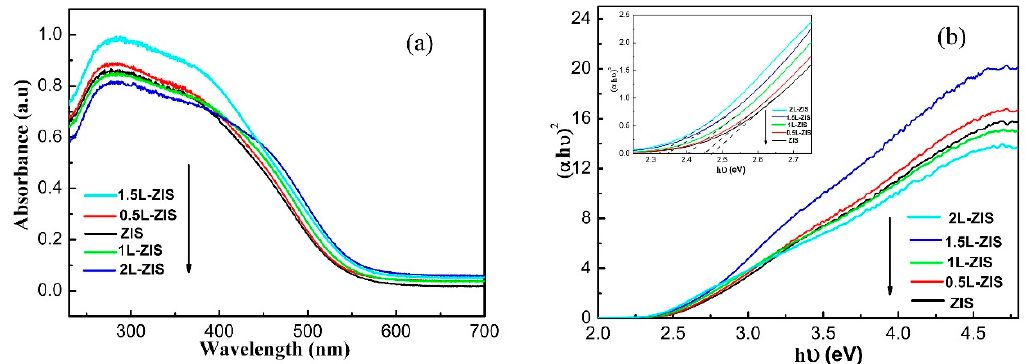
Figure 7. ( a ) Ultraviolet–visible (UV–vis) absorbance spectra of P-ZIS and La-doped ZIS samples; ( b ) the derived plots of ( α hv ) 2 versus hv from the absorption spectrum for P-ZIS and La-doped